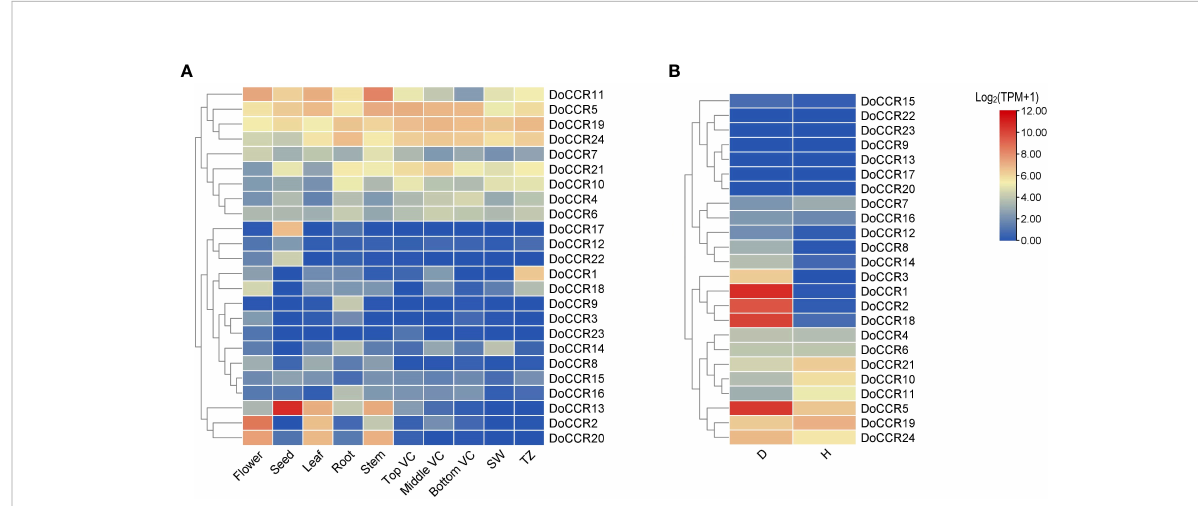
FIGURE 6 Expression pro fi les of DoCCR genes in different tissues and under abiotic stress. (A) The accumulation patterns of DoCCRs in different tissues, such as fl ower, seed, leaf, root, stem, top (Top VC), middle (Middle VC), and bottom (Bottom VC) of vascular cambium, sapwood (SW), transition zone (TZ). (B) The expression patterns of DoCCRs in stems after wounding treatment. Discolored (D), and healthy (H) zones of pruning-induced stems were assayed. Scale bars on the right represent log 2 (TPM+1) transformed